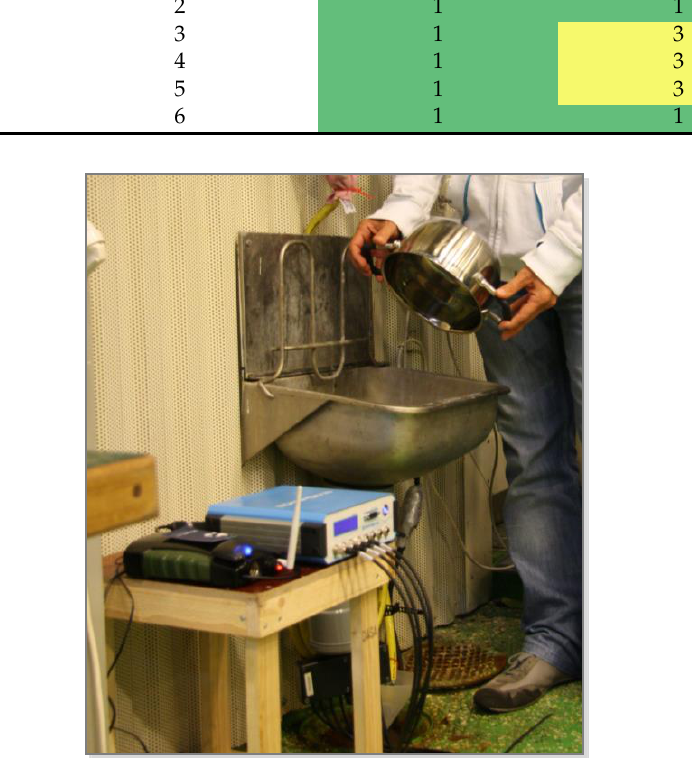
Figure 4 . EC sensor experimental set-up used during the final demonstration carried out at FOI (Grindsjön).